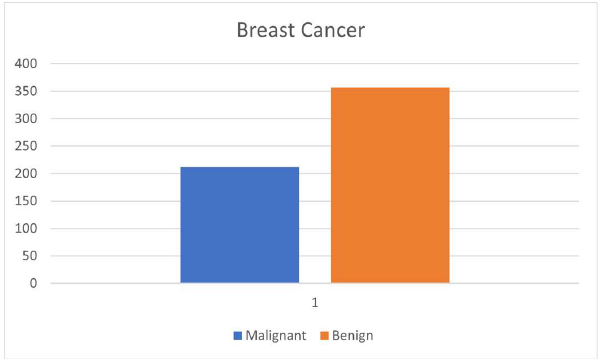
Figure 5. Graphic representation of dataset in